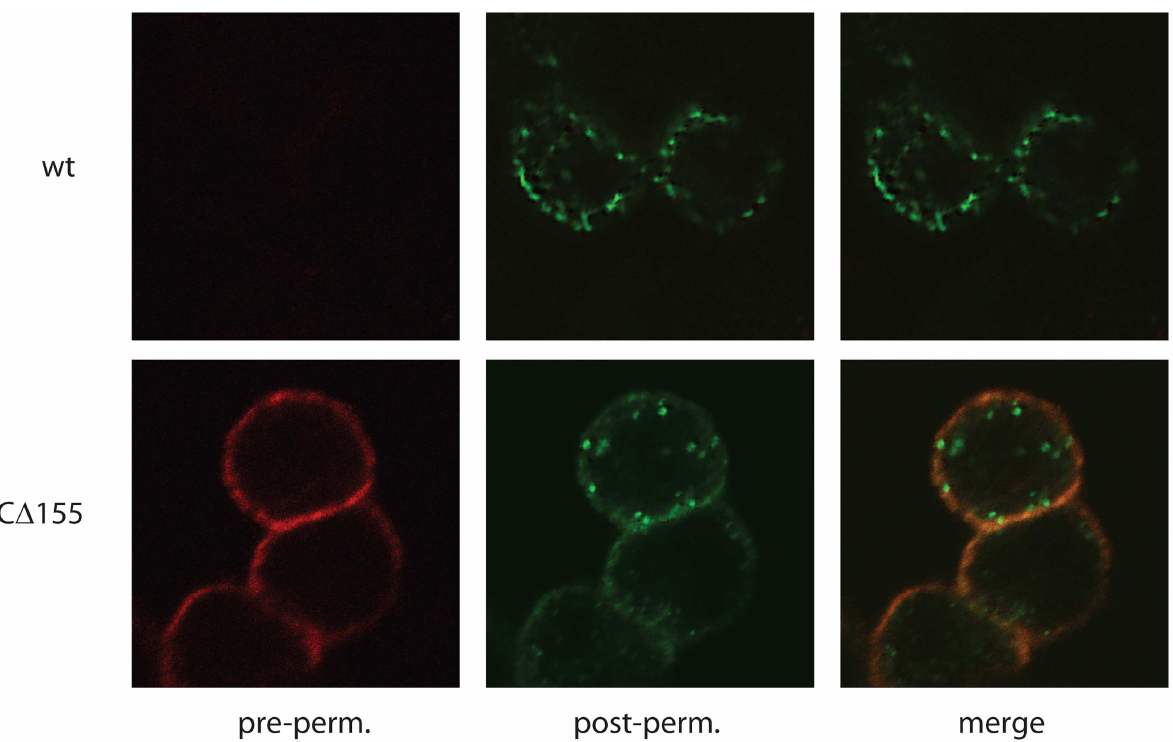
Fig 1. The M78 cytoplasmic C-tail is required for rapid, constitutive endocytosis. Hela cells were transfected with plasmids expressing HA-tagged M78, either wild type (wt) or C-terminally truncated (C Δ 155). 1 day post-transfection, cells were fed primary rabbit anti-HA antibody (1hr, 37degs) then stained with secondary anti-rabbit IgG either before (pre-perm. AF 594 conjugate)or after (post- perm. AF 488 conjugate)permeabilisation. Confocal images are shown for AF 594 (red), AF 488 (green) or the merged